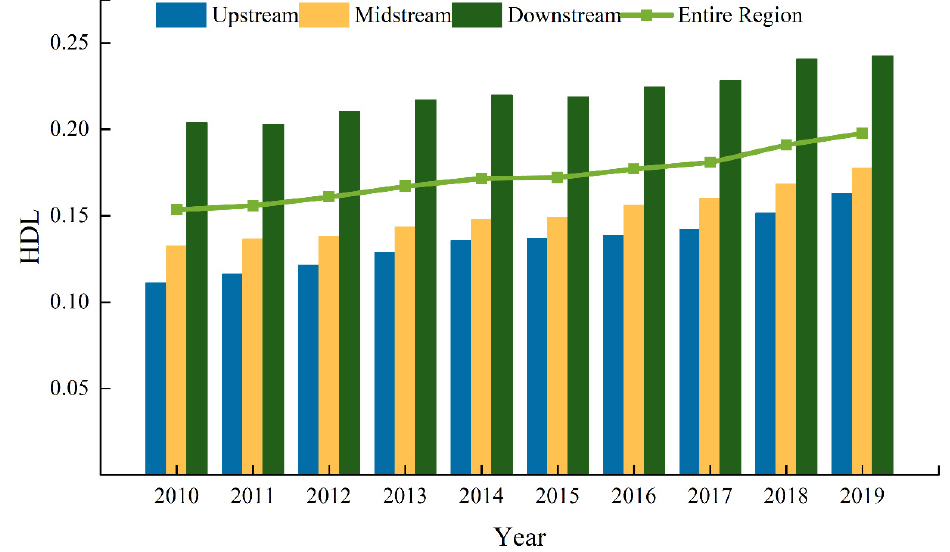
Figure 2. The average value of YREB subregional HDL from 2010 to 2019. Table 3. HDL of cities in the YREB in 2010, 2015, and 2019.